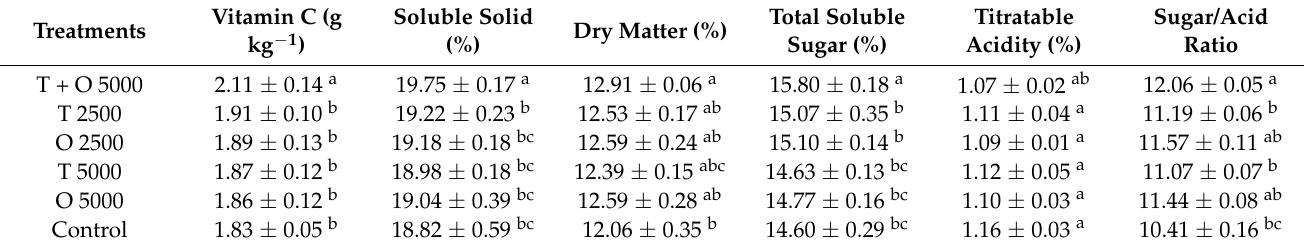
Table 6. The effects of tebuconazole and oligosaccharins on kiwifruit’s